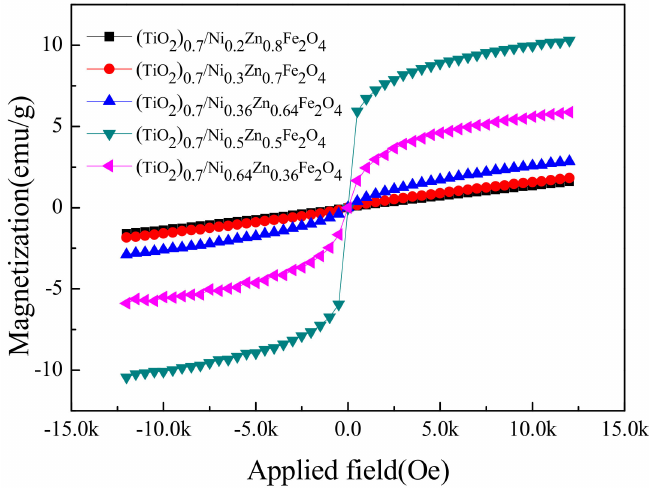
Figure 8. The influence of cladding with TiO 2 on the magnetic properties of [Ni x Zn 1 − x ]Fe 2 O 4 .